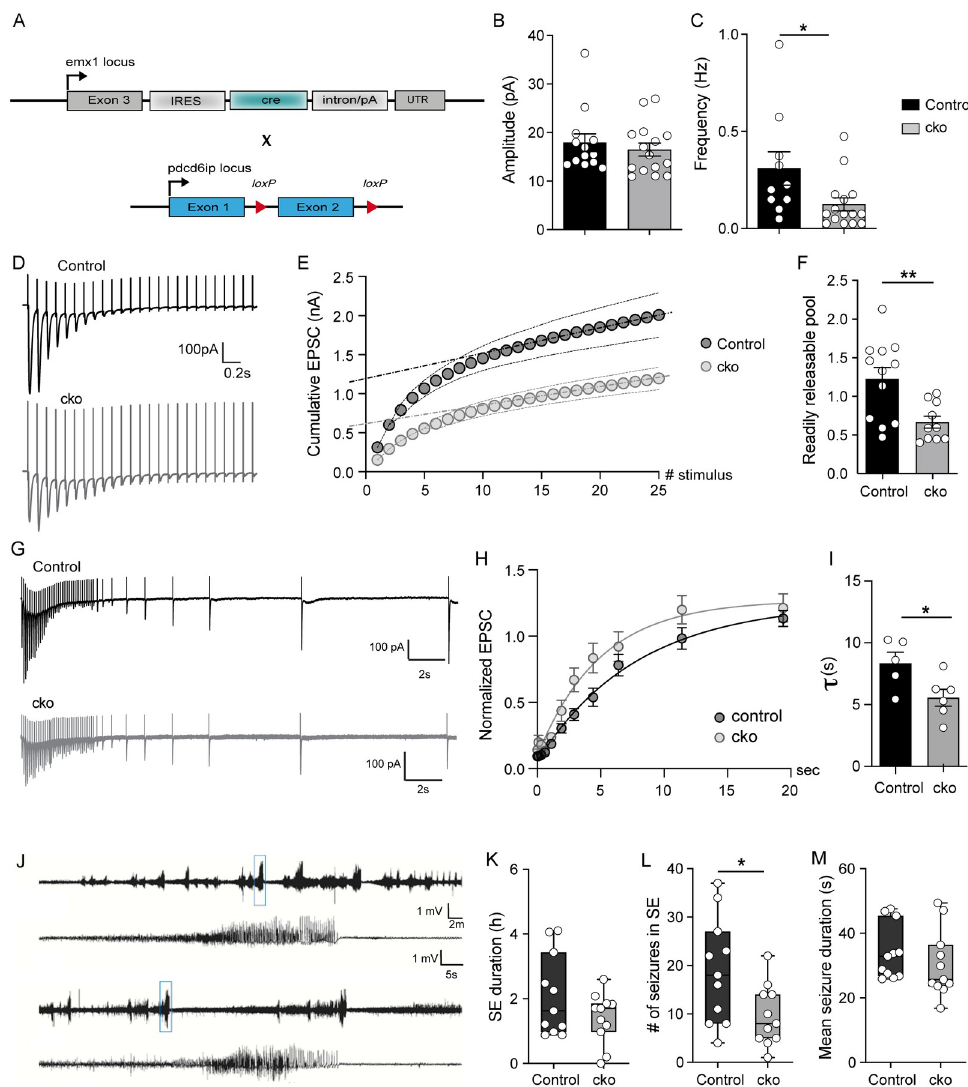
Fig 5. Alterations of Alix ko synapses revealed in hippocampal slices and in an in vivo model of epilepsy. ( A ) Emx1 IREScre (Emx-Cre) and Alix fl/fl mouse lines were crossbred to delete Alix in neocortical and hippocampal excitatory neurons (Alix cko). ( B ) No difference in sEPSC amplitude was detected between control and cko mice. ( C ) The frequency of sEPSC in cko neurons is lower compared to control. ( D ) Representative traces showing short-term depression in response to 10 Hz stimulation trains in control (black) and cko (gray) mice. ( E ) Cumulative EPSC amplitudes in response to 10 Hz stimulation. Train-extrapolation is illustrated by the dashed line. ( F ) The size of the RRP, estimated by the train- extrapolation method, was significantly decreased in Alix cko mice. ( G ) Representative traces showing recovery from depression in response to 10 Hz stimulation trains in control (black) and Alix cko (gray) mice. ( H ) To evaluate the speed of recovery, all inward signals were normalized to the first inward current. Recovering signals with a single-exponential function revealed the plateaus at which the capacities of recovery were saturated. ( I ) Alix cko neurons recover slightly faster than controls. ( J ) Representative EEG traces from control and Alix cko mice. ( K ) Total duration of SE did not differ between Alix cko and control mice. ( L ) Alix cko mice experience about 66% fewer seizures during SE than controls. ( M ) Mean seizure duration during SE was not affected in Alix cko mice compared to controls. Average +/ − SEM, N , statistical analysis: (B) 17.93 +/ − 1.81; 16.49 +/ − 1.35 for controls and Alix cko, respectively. N = 13 neurons from 5 control mice and N = 15 neurons from 6 Alix cko mice. (C) 0.31 +/ − 0.09; 0.12 +/ − 0.03 for controls and Alix cko, respectively. N = 10 neurons from 5 control mice and N = 15 neurons from 6 Alix cko mice. Control vs. cko, p = 0.015, Mann–Whitney test. (F) 1.23 +/ − 0.15; 0.67 +/ − 0:08 for controls and Alix cko, respectively. N = 12 neurons from 5 control mice and N = 10 neurons from 4 Alix cko mice. Control vs. cko, p = 0.0052, unpaired t test. (I) 8.34 +/ − 0.90; 5.56 +/ − 0.69 for controls and Alix cko, respectively. N = 5 and 6 neurons from 3 mice from control and Alix cko, respectively. Control vs. cko, p = 0.0336, unpaired t test. Median (IQR), N , statistical analysis: (K) Control: 1.6 h (IQR = 2.5); cko: 1.7 h (IQR = 0.9).